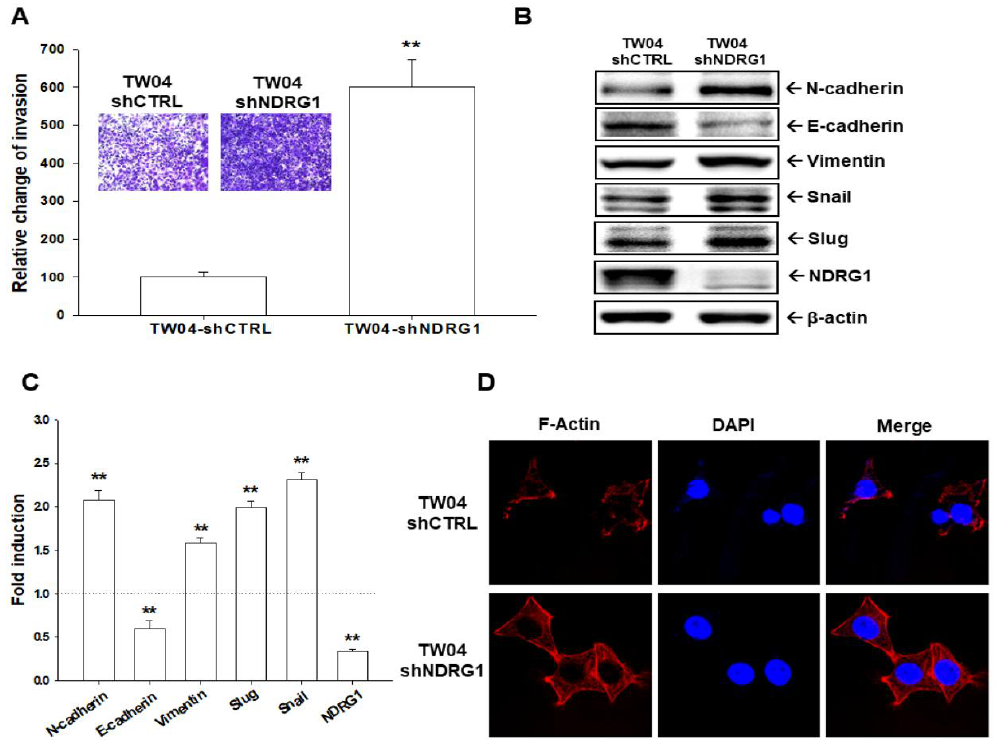
Figure 4. Knockdown of NDRG1 enhances cell invasion and induces epithelial–mesenchymal transition in TW04 cell. ( A ) The cell invasion of TW04-shCTRL and TW04-shNDRG1 were measured by the matrigel-invasion assay for 24 h incubation. The quantitative data were expressed as mean average ( ± SE, n = 6) relative to the TW04-shCTRL cells. ( B ) The expressions of targeted proteins in